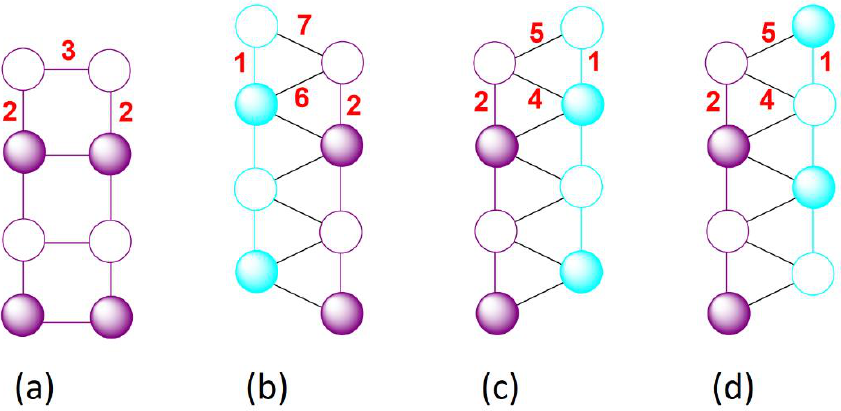
Figure 7. ( a ) Ferromagnetic coupling between two adjacent J 2 -chains. ( b ) Ferromagnetic coupling between two adjacent J 1 - and J 2 -chains when the ( J 1 , J 6 , J 7 ) and ( J 2 , J 6 , J 7 ) exchange triangles are not spin-frustrated. ( c , d ) Two possible spin arrangements between two adjacent J 2 - and J 1 -chains when the ( J 1 , J 4 , J 5 ) and ( J 2 , J 4 , J 5 ) exchange triangles are